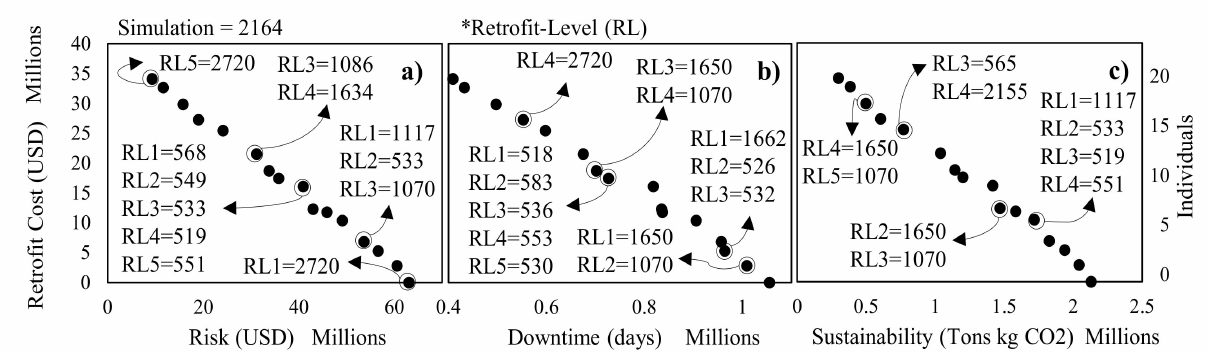
Figure 11. Pareto-optimal solutions of performance indicators against retrofit costs for ( a ) Risk, ( b ) Downtime, and ( c )